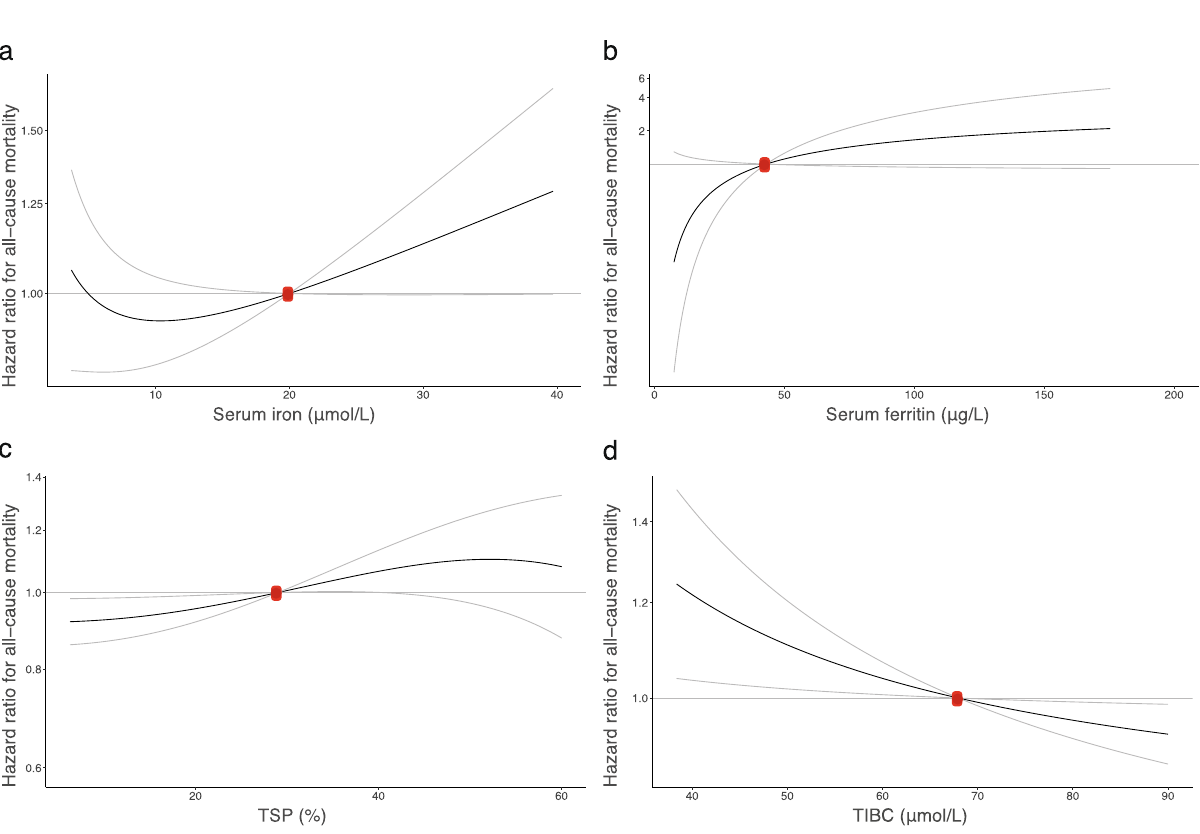
Fig. 2 Non-linear Mendelian Randomization: causal associations between iron status biomarkers and all-cause mortality. Dose-response curves (black) between iron traits and all-cause mortality in HUNT (gray lines give 95% con fi dence interval). The x -axis gives a : serum iron levels ( µ mol/L) [ N = 56,654], b : serum ferritin ( µ g L − 1 ) [ N = 2335], c : transferrin saturation (%) [ N = 56,651] and d : total iron-binding capacity (TIBC) ( µ mol L − 1 ) [ N = 56,654]. The y - axis gives the hazard ratios for all-cause mortality with respect to the reference values (red dot), which represent the established target values (iron, TIBC, TSP) 84 or median value (ferritin) for the traits. The curve gradients represent the localized average causal effect at each point. N = sample